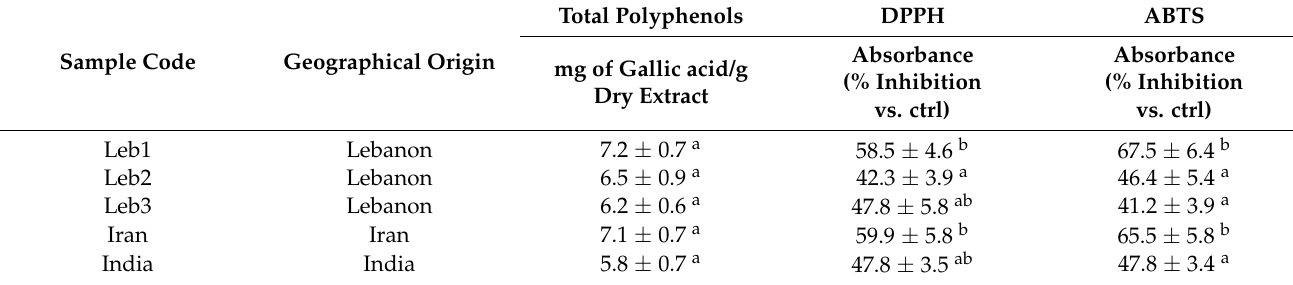
Table 1. Polyphenol content and antioxidant capacity by ABTS and DPPH radical scavenging assays.